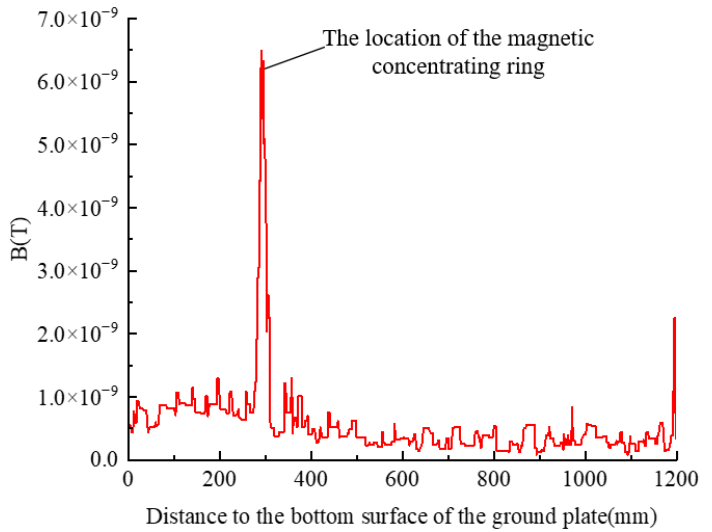
Figure 9. Magnetic flux density changes the curve through the air gap of the magnetic concentrating ring.